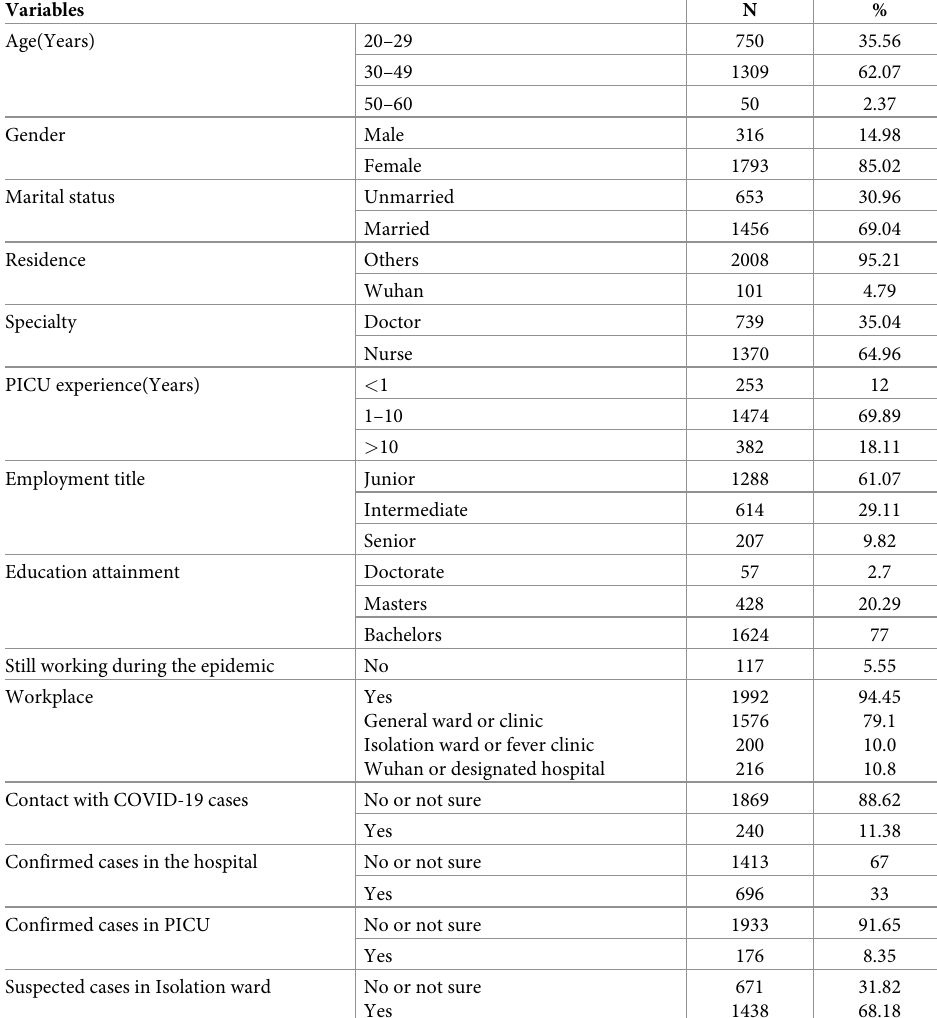
Table 1. Socio-demographic characteristics of participants (n =